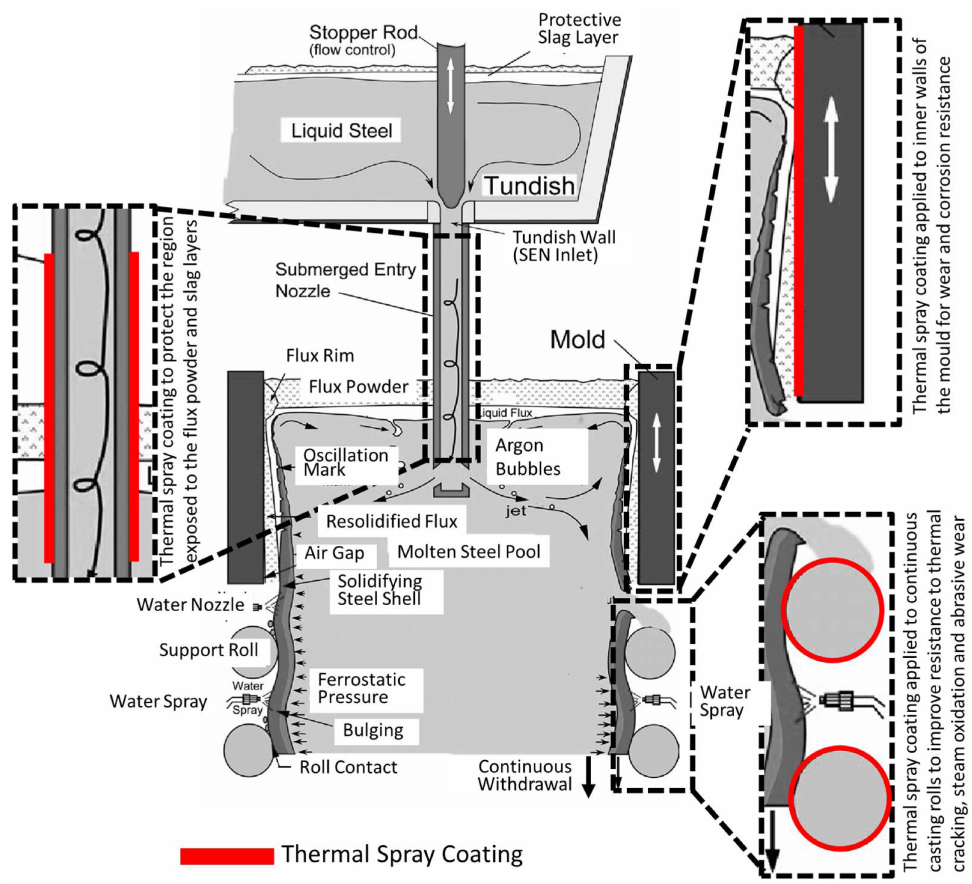
Figure 9. Schematic diagram representing the continuous casting process and potential applications of thermal spray coatings. Reproduced with permission from [43]. 2017, John Wiley and Sons. Application of wear resistant, low wettability, high hardness and low-cost coatings on the inside liner of moulds increases their working life. The ‘working life’ refers to the time period through which the mould shows acceptable dimensional stability for steel production [44]. Laser cladding based on TiC/CaF 2 self-lubricating alloys have